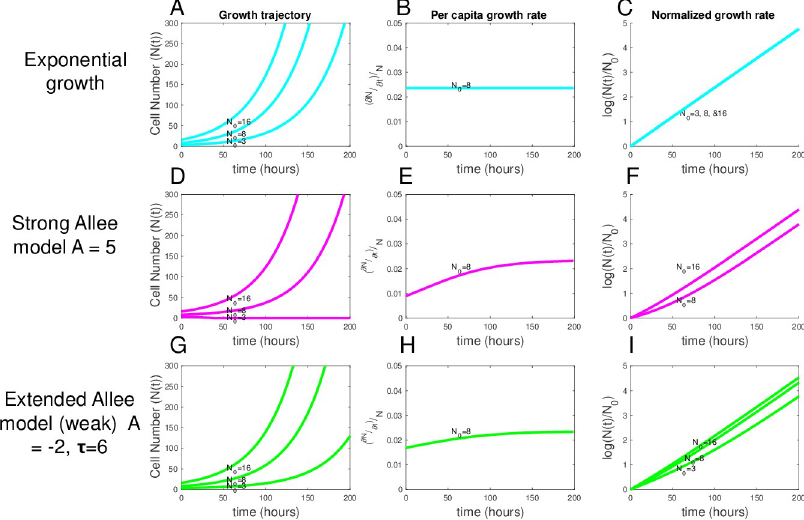
Fig 1. Average behavior of exponential, strong, and weak Allee models for different initial conditions. (A, D, and G) Deterministic growth curves of the exponential growth model (blue), the strong Allee model (pink), and the weak Allee model (green), respectively, shown for N 0 = 3, 8, and 16 for all models. (B, E, and H) Per capita growth rates demonstrate that growth rate increases in time with cell number for both Allee models. (C, F, and I) For normalized cell numbers, a clear difference is observed in the slopes depending on the initial cell number for both Allee models. Data and code used to generate this figure can be found at https://github.com/brocklab/Johnson-AlleeGrowthModel.